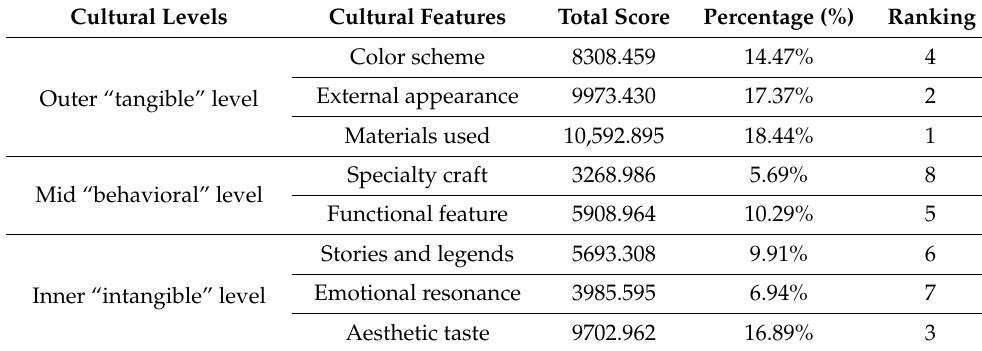
Table 3. Total attention score of cultural